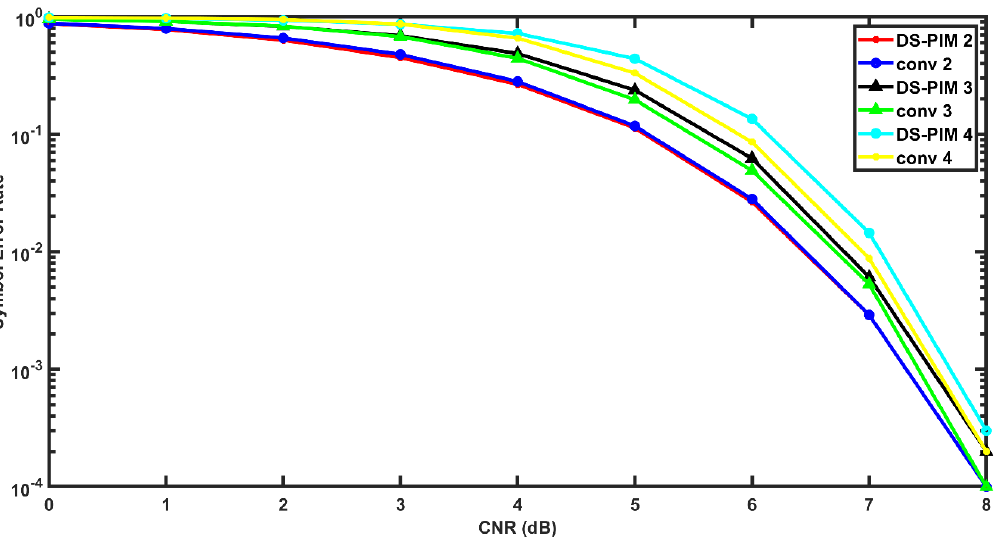
Figure 11. CNR vs. SER of conventional and DS-PIM based SIM OFDM for index word lengths of 2 – bits, 3 – bits and 4 – bits.